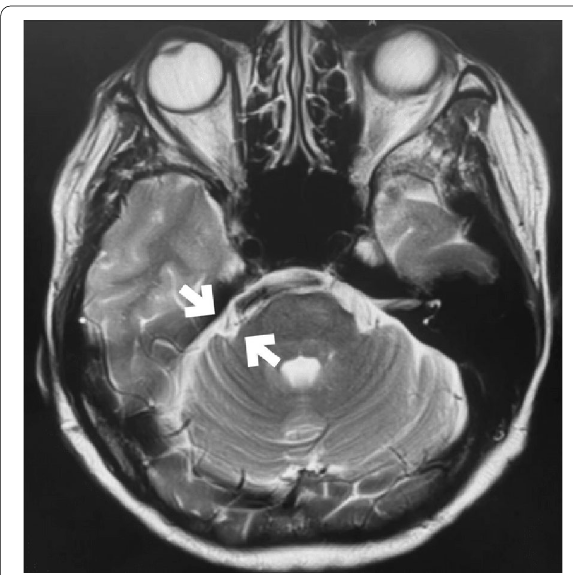
Fig. 2 The VBD (bow) and its compression (arrow), 8th nerve compression (orange